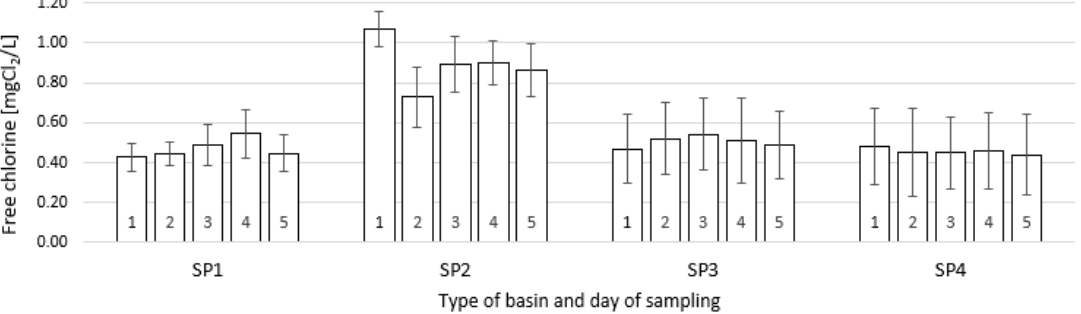
Figure 6. The daily variability of free chlorine in different swimming pools.